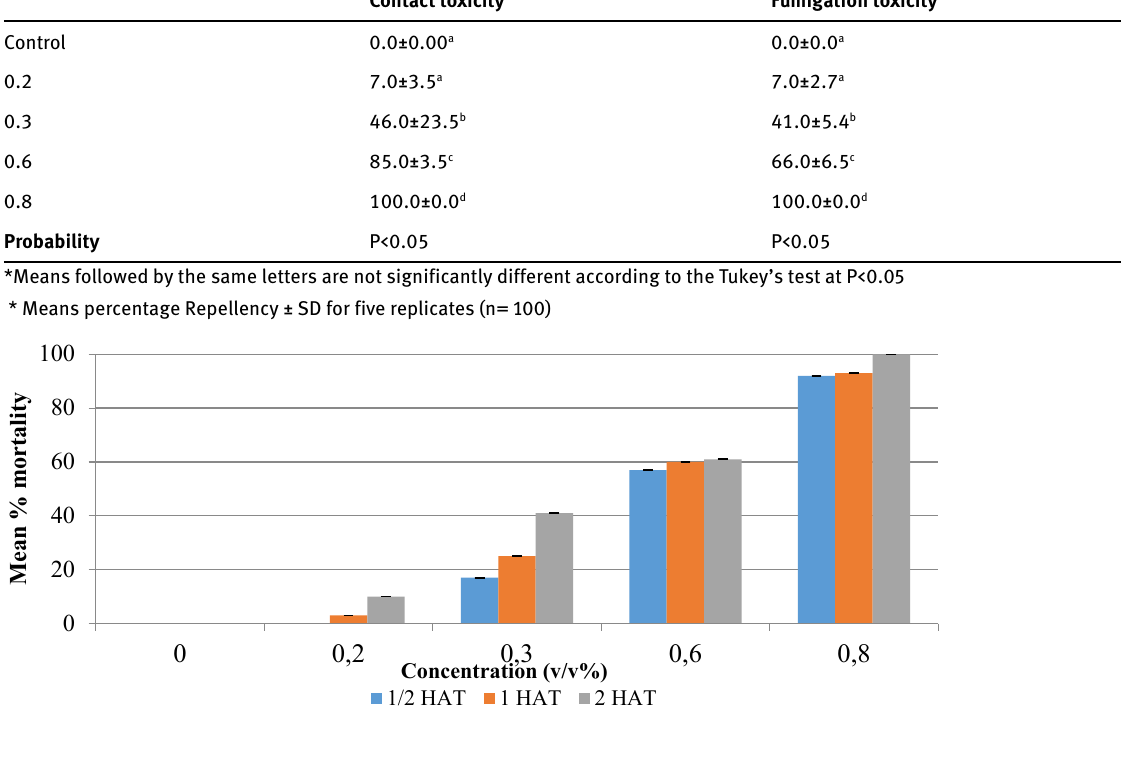
Figure 4: Mean percentage mortality of oil from P. dioica on C. maculatus after 1/2, 6 and 12 hours in the contact toxicity test HAT – Hours After